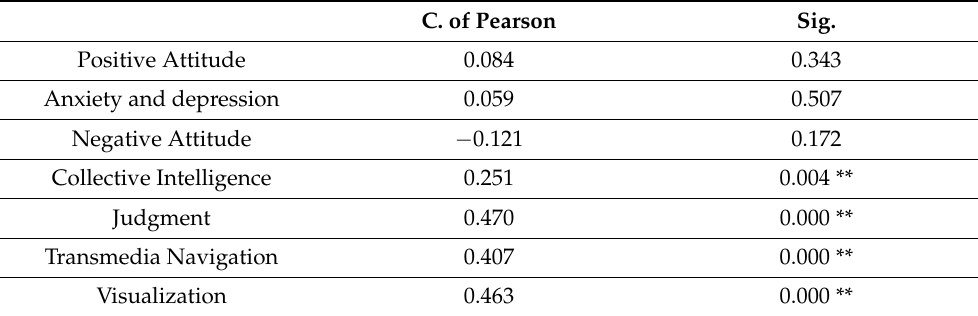
Table 7. Correlations with digital literacy (** sig > 0.01). Source: Authors’